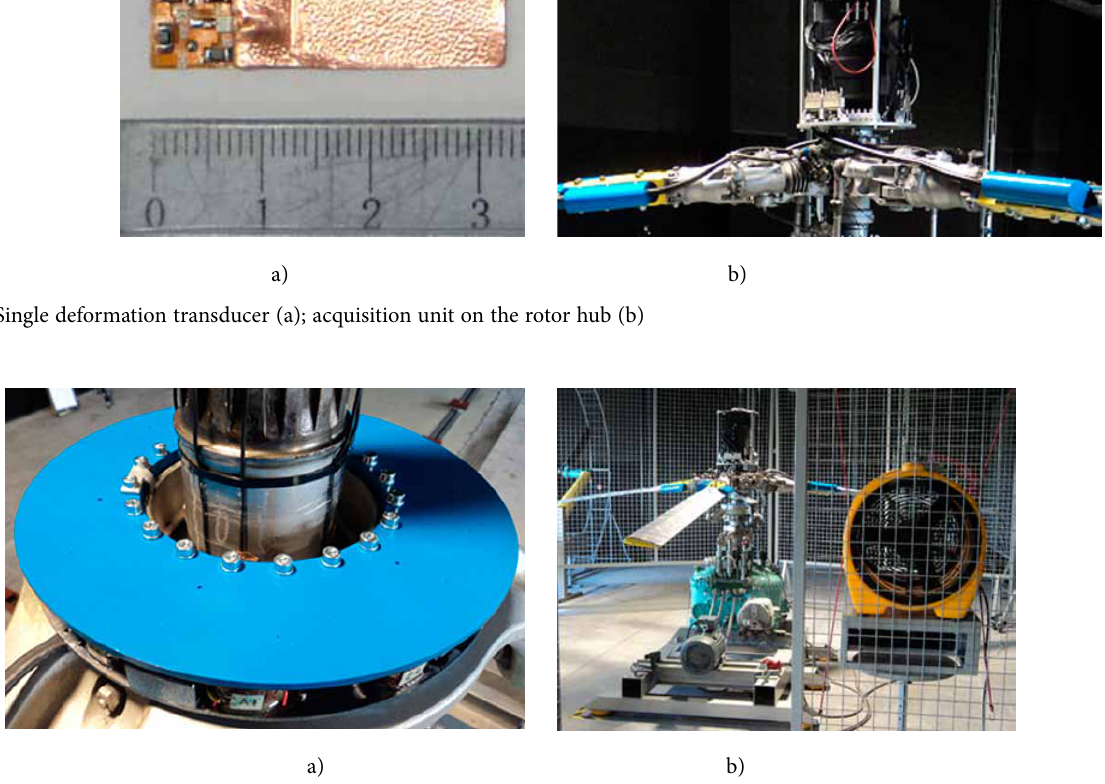
Fig. 5. Photo of the electric generator of the harvesting system (a); the rotor test bench with the fan creating turbulent flow (b)